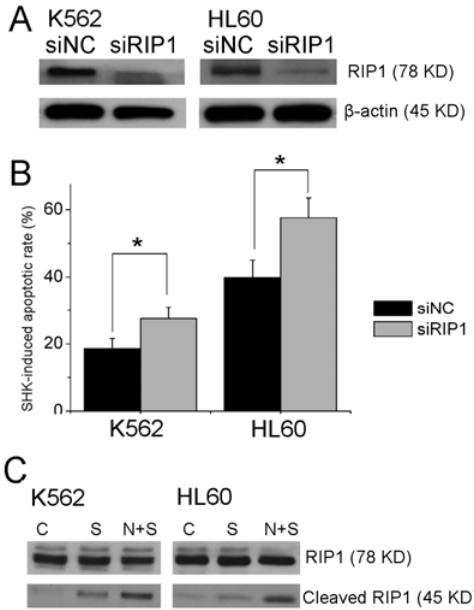
Figure 4. Knockdown of RIP1 sensitizes shikonin-induced apoptosis. ( A ) HL60 and K562 cells were transiently transfected with control siRNA or RIP1 siRNA. The knockdown efficiency was determined by Western blot 48 h post-transfection; ( B ) Cells transiently transfected with negative control or RIP1 siRNA were treated with 1.25 μ M (HL60) or 2.5 μ M (K562) SHK for 12 h. Cells apoptotic rate was measured as described in Materials and Methods; ( C ) HL60 and K562 cells were treated with shikonin in the absence or presence of Nec-1 for 12 h. The cleavage of RIP1 was detected by Western blot. Data are mean ± SD or representative of at least three independent experiments, and analyzed by Student’s t test. * p <